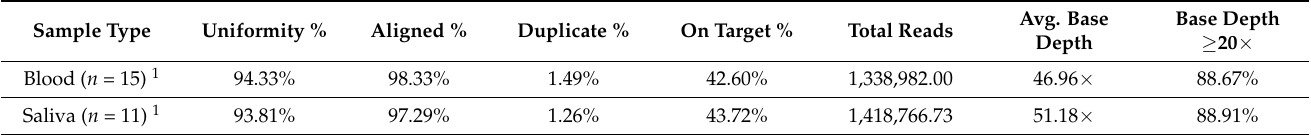
Table 2. Comparison of quality metrics in blood versus saliva specimens.